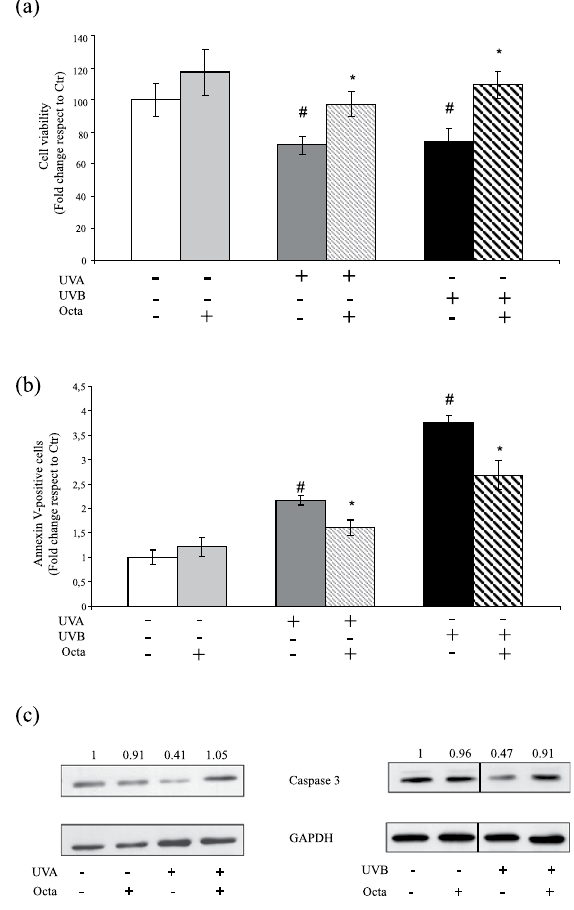
Figure 2. Octa pre-treatment protects NHKs from UVA and UVB-induced cell death and apoptosis. ( a ) NHKs were irradiated with UVA 10 J/cm2 or UVB 25 mJ/cm2 after a 24 h pre-treatment with 90 µ M Octa. Viability was evaluated by Neutral Red assay 48 h after irradiation. The values reported represent means ± SD of three independent experiments performed in quadruplicate. # p < 0,005 (vs untreated cells), * p < 0,01 (vs UV- irradiated cells) ( b ) NHKs were pre-incubated with 90 µ M Octa for 24 hrs and irradiated with UVA 10 J/cm2 or UVB 25 mJ/cm2. Apoptosis was evaluated by FACS analysis 16 h after irradiation, using annexin V labelling. The values reported represent means ± SD of three independent experiments performed in duplicate. # p < 0,005 (vs untreated cells), * p < 0,01 (vs UV-irradiated cells) ( c ) NHKs were pre-treated with 90 µ M Octa for 24 h and then irradiated with UVA 10 J/cm2 or UVB 25 mJ/cm2. Proteins were extracted 16 h later and Western blot analysis of caspase 3 protein expression was performed. GAPDH was used as a loading control. Results refer to three independent experiments. Representative blots are shown. Densitometric scanning of band intensities was performed to quantify the change of protein expression (control value taken as one fold in each